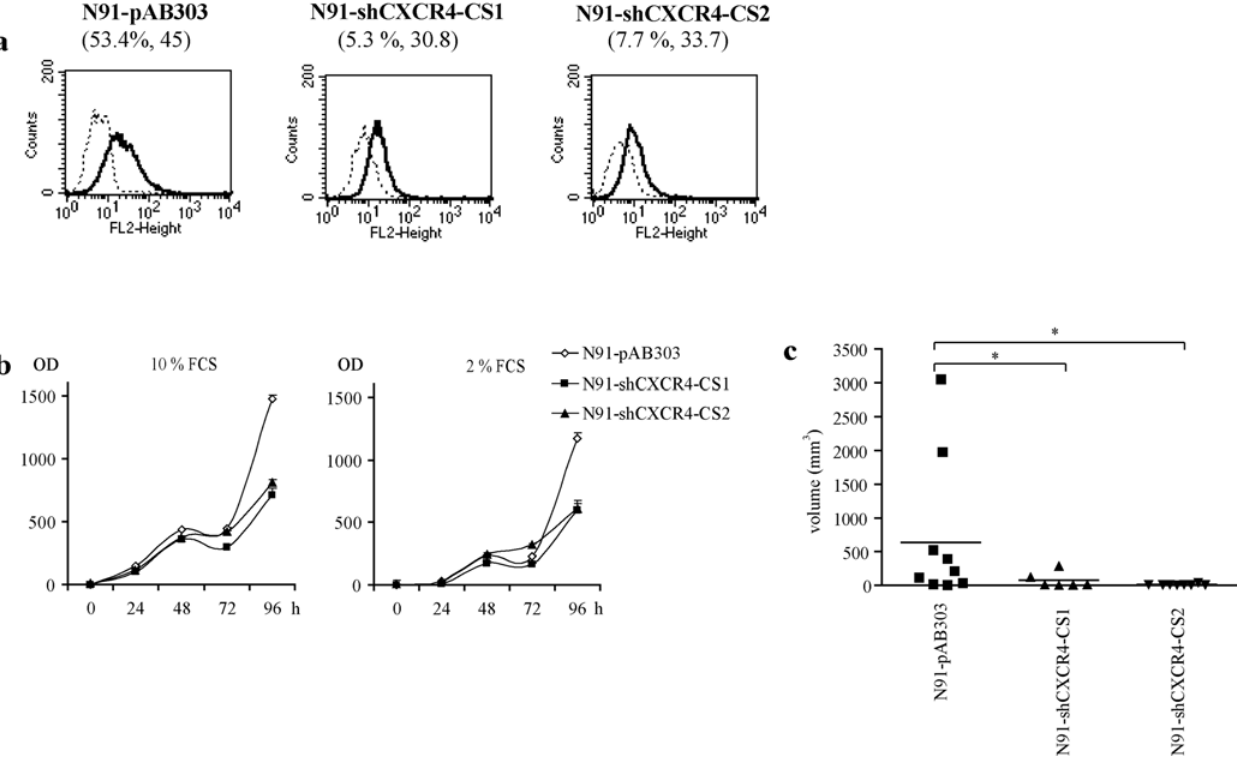
Figure 6. (a) FACS profiles of shRNA-mediated cell surface CXCR4 silencing in N91-shRNA-CS1 and N91-shRNA-CS2 clones and N91-pAB303 control cells. Percent positive cells is indicated as well as the mean fluorescent intensity (brackets) of the CXCR4 staining. (b) In vitro growth capacities of N91- shRNA-CS1, N91-shRNA-CS2 clones and N91-pAB303 control cells. (c) In vivo growth capacities of IGR-N91 cells were CXCR4 has been knocked down by shRNA. Comparison of tumour volumes after 44 days when mice were sacrificed. * indicates p , 0.05 (Mann-Whitney